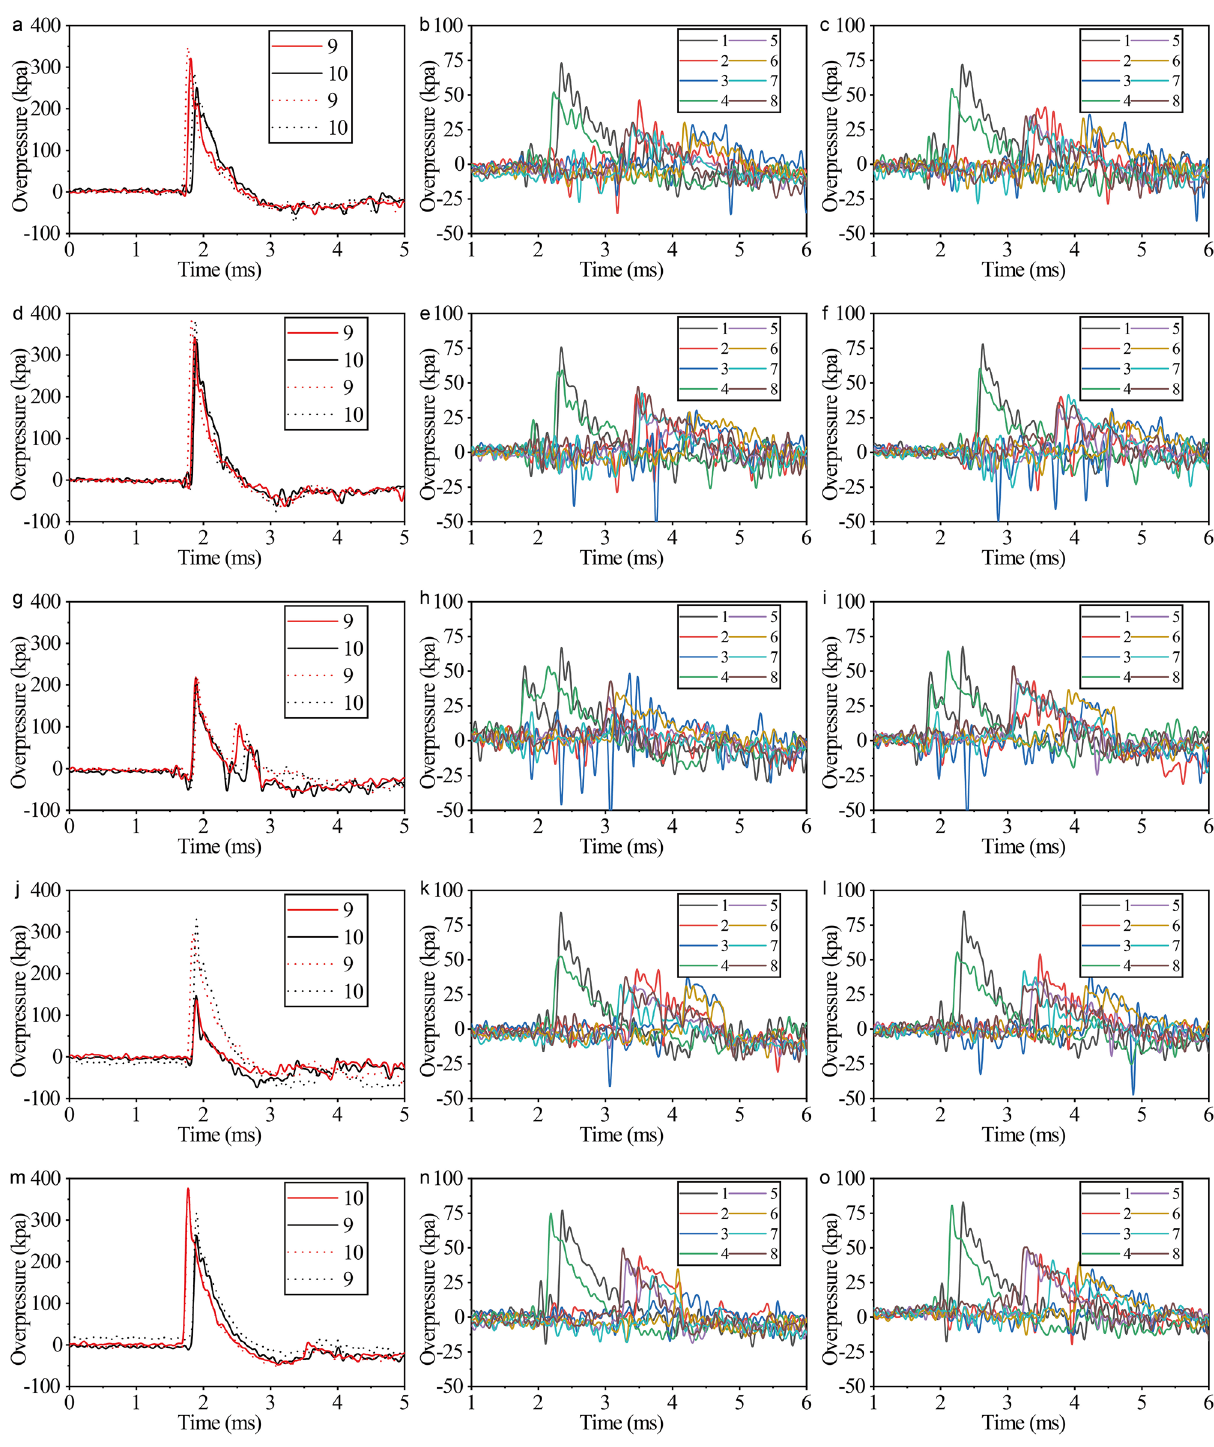
Figure 3. Overpressure-time histories. ( a-c ) Case 1 (adapted from Ref. 15 ). ( d-f ) Case 2. ( g-i ) Case 3. ( j-l ) Case 4. ( m–o ) Case After the primary shock wave separating from the fireballs, it rapidly evolves into an ellipsoid wave (Fig. 5a), and then collides with the end face and forms a reflected wave (Fig. 5b), finally, the reflected wave collides with the secondary shock wave (Fig. 5c) to form a high-pressure area and bounce back 15,34,35 , the two waves seem to remain in their original trajectories without interference (Fig. 5d). Whether cylindrical charges are detonated in the air 36,37 or on the ground, the blast waves expand faster along the radial direction of cylindrical charges (Fig. 5e,f) than along the axial direction (Fig. 5i,j), therefore, the blast loads are relatively large (Fig. 3) when the radial plane of cylindrical charges (Slenderness ratio L/D = 1.58) passes